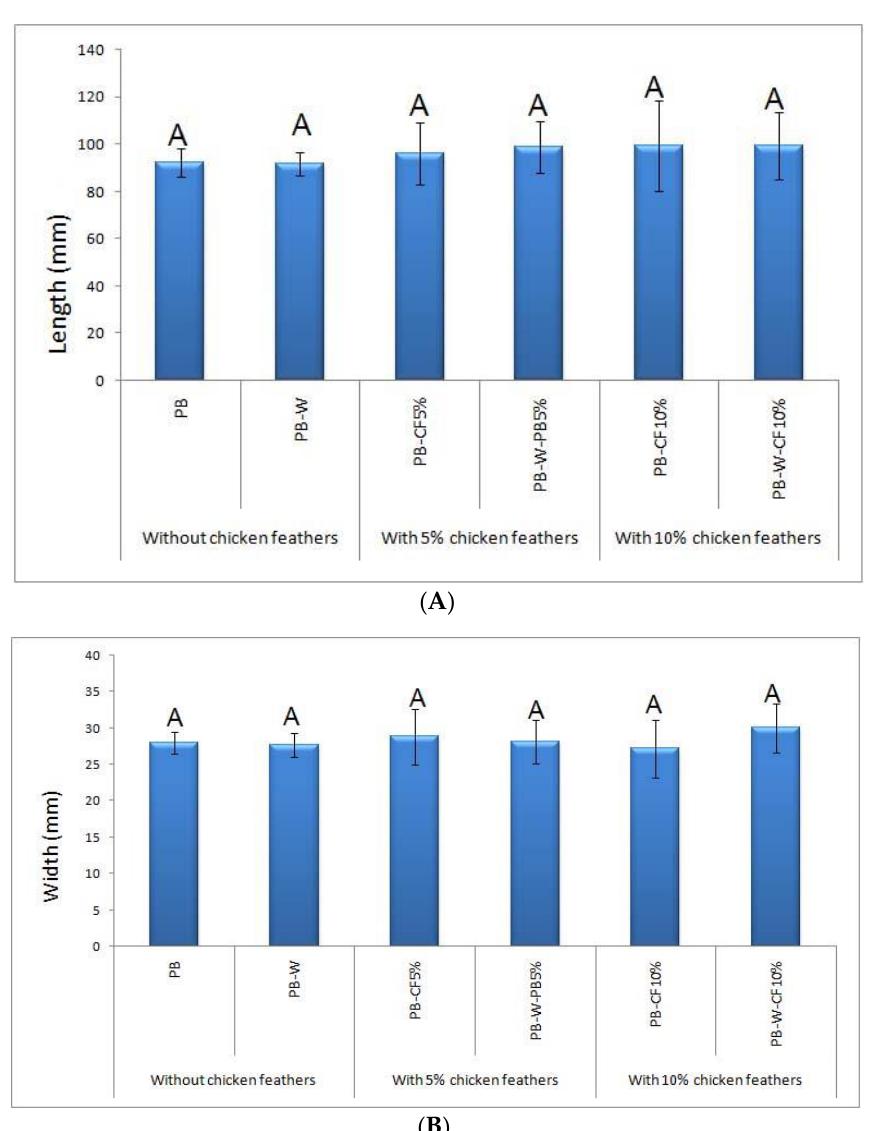
Figure 3. Duration of burning (in seconds) after the removal of piloted fire, in the six particleboard panels made from wood chips and the two chicken feather contents of 5% and 10%, containing 10% wollastonite (PB = particleboard panels; W = panels containing wollastonite; CF = chicken feather content) (letters on each column bar represent groupings based on Duncan’s multiple range test, α = 0.05).